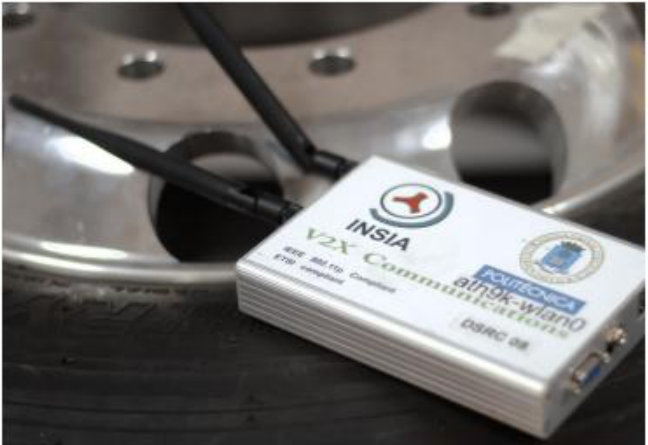
Figure 3. DSRC INSIA communication module.